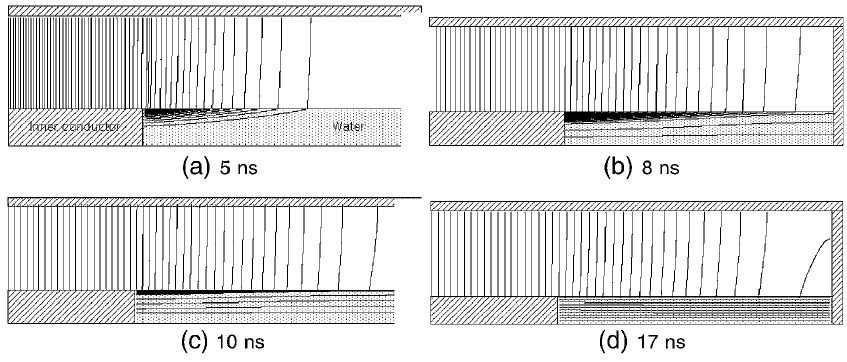
FIG. 5. Electric flux lines in the water load when the propagation waves are penetrated into